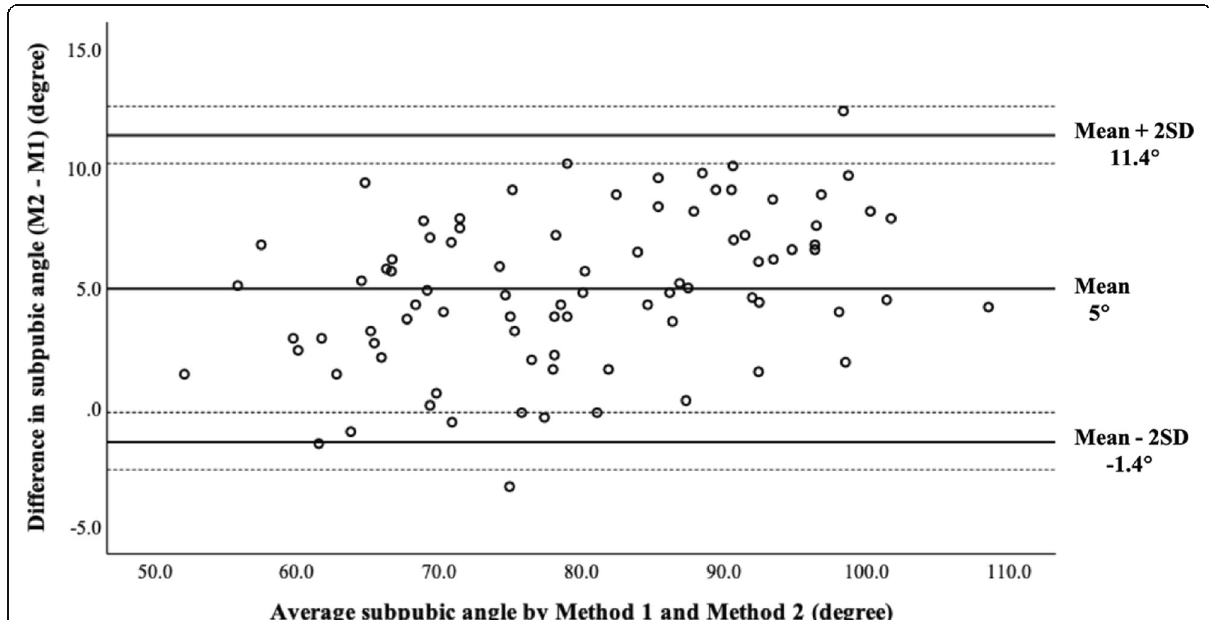
Fig. 4 Differences between subpubic angle measurements plotted against the average with the 95% limits of agreement and confidence intervals (as dashed lines). (Method 1 – Checkpoint, Method 2 – MeshLab +